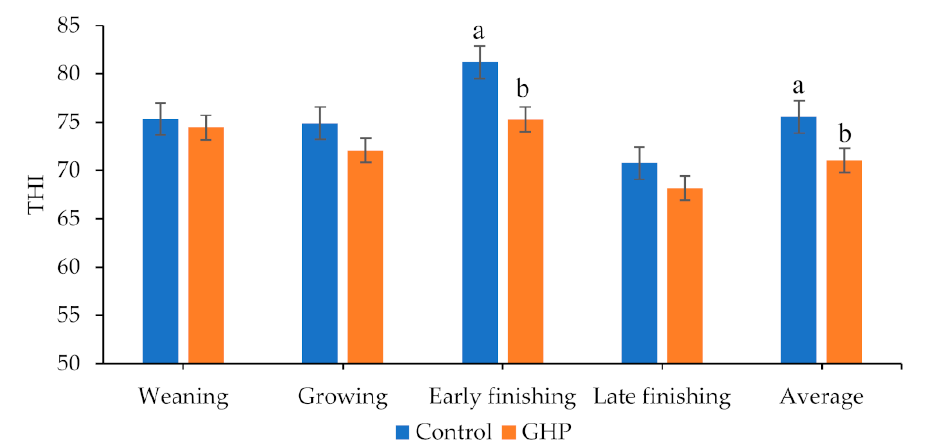
Figure 4. Effect of the GHP cooling mode on the temperature–humidity index (THI). The data are presented as the mean ± SEM. a,b Values with different superscripts within the same bars differ significantly ( p < 0.05).